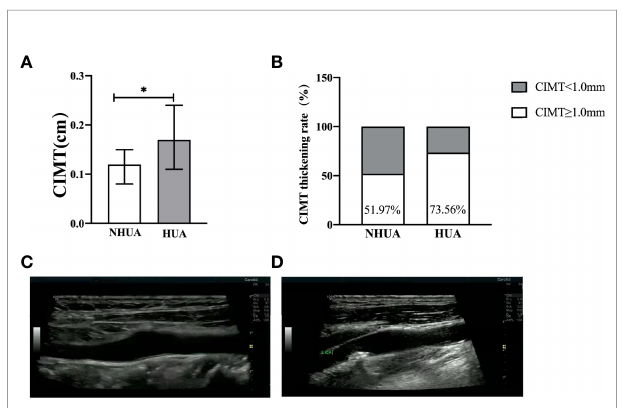
FIGURE 1 | (A, B) Comparison of CIMT and CIMT thickening rate between the normouricemia and hyperuricemia groups. CIMT and the CIMT thickening rate in the hyperuricemia group were signi fi cantly higher than those in the normouricemia group ( p < 0.001). (C, D) The B-ultrasound image of the normal carotid intima-media thickness and carotid intima-media thickness thickening. NHUA: normouricemia group (n = 406); HUA, hyperuricemia group (n = 208). * p < 0.05.